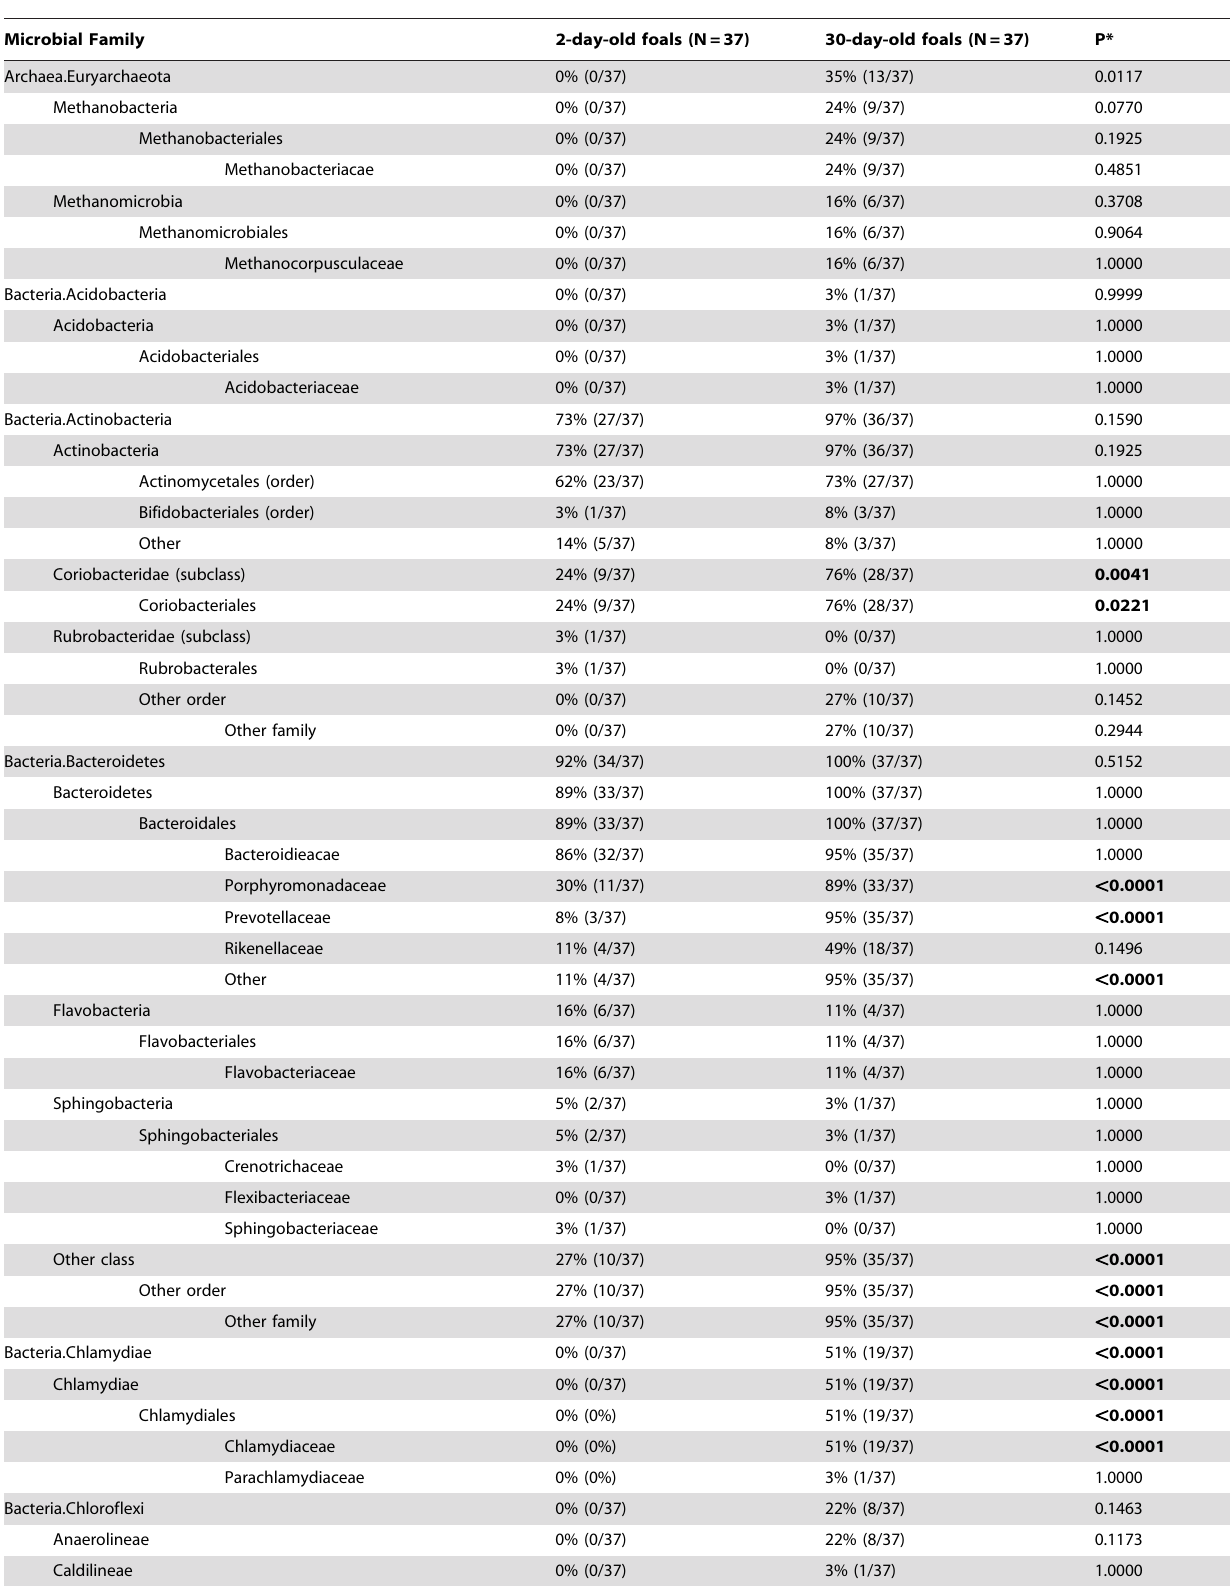
Table 3. Median and range proportion of foals with sequences detected in the fecal DNA of rectal swab samples (Phylum, class, order, and